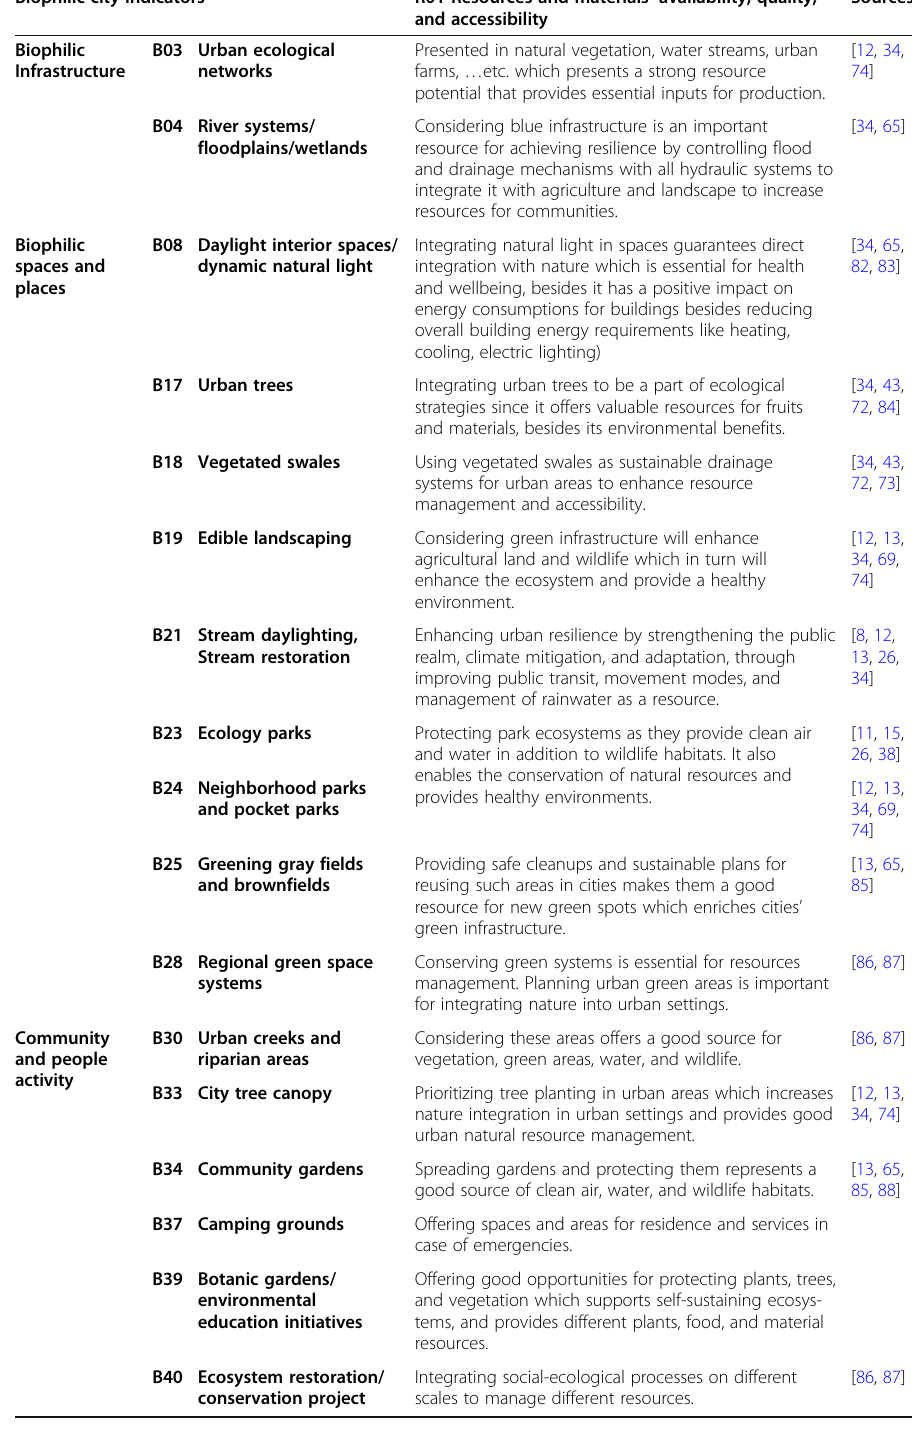
Table 3 Illustration for biophilic city indicators and R01 principle of urban resilience Biophilic city